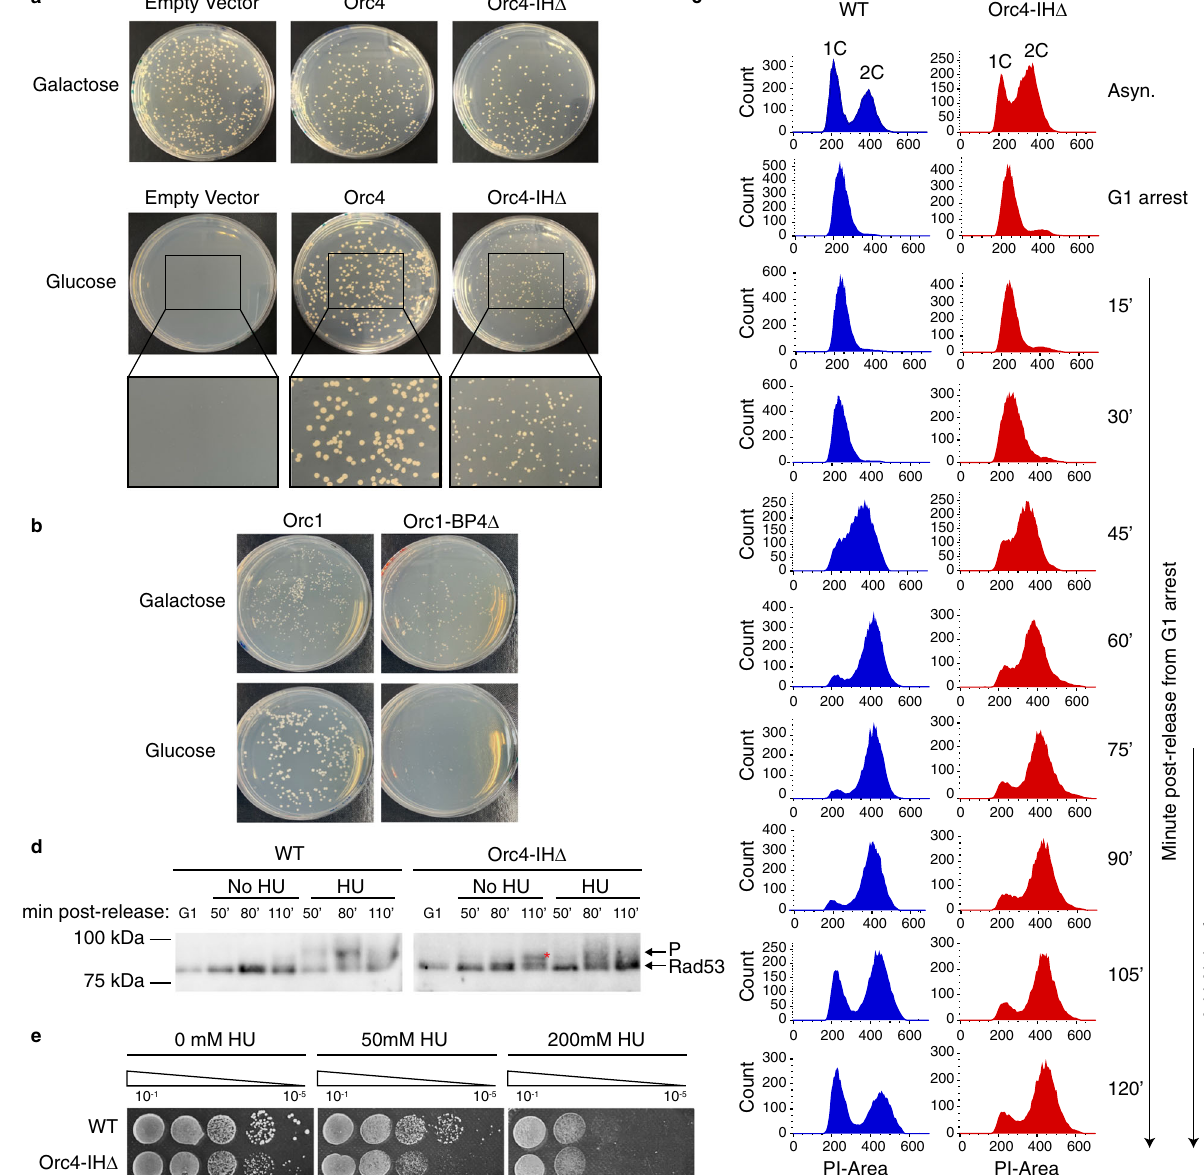
Fig. 2 Yeast strain with Orc4-IH Δ has normal S-phase but prolonged G2 phase. a GALS-ORC4 yeast strains ectopically expressing Orc4, Orc4-IH Δ , or vector alone control were plated on SCM-Ura plates containing either galactose or glucose. Zoom-in views of 2× magni fi cation were shown for the glucose selection plates. b GALS-ORC1 yeast strains ectopically expressing Orc1 or Orc1-BP4 Δ were plated on SCM-Ura plates containing either galactose or glucose. c FACS analysis shows Orc4-IH Δ cells exhibit normal S-phase progression yet delayed G1 entry from G2M. WT and mutant cells were fi rst arrested in G1 and then released into S-phase. Alpha factor was added to the cultures at 75 min post release from G1 to monitor G1 entry from G2M. d S- phase checkpoint activation assayed by Rad53 phosphorylation. WT and mutant cells were arrested in G1 using alpha factor (G1), and released into YPD without hydroxyurea (no HU) or YPD containing 200 mM HU (HU) for the indicated times at 30 °C. Trichloroacetic acid (TCA) lysates were prepared for western blotting. Rad53 is phosphorylated in mutant, but not in the WT in the absence of HU. (*) denoted the phosphorylated state of Rad53. Blots shown are representative of n = 3 biological replicates. Source data are provided as Source data fi le. e HU sensitivity is assayed by spotting serially diluted WT and mutant cells onto YPD plates containing the indicated concentrations of